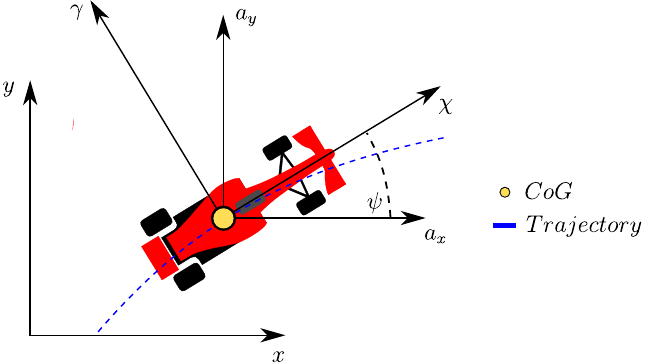
Figure 2. Global and vehicle coordinate